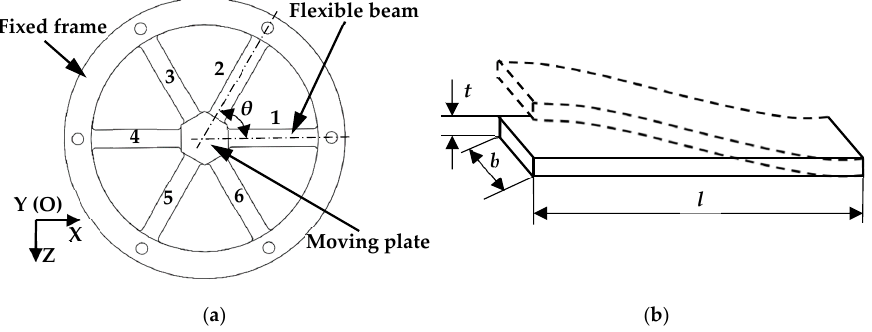
Figure 2. Design parameters of the CEE: ( a ) overall structure; ( b ) the parameters of the flexible beam. Table 1. Key parameters of the flexible beam.